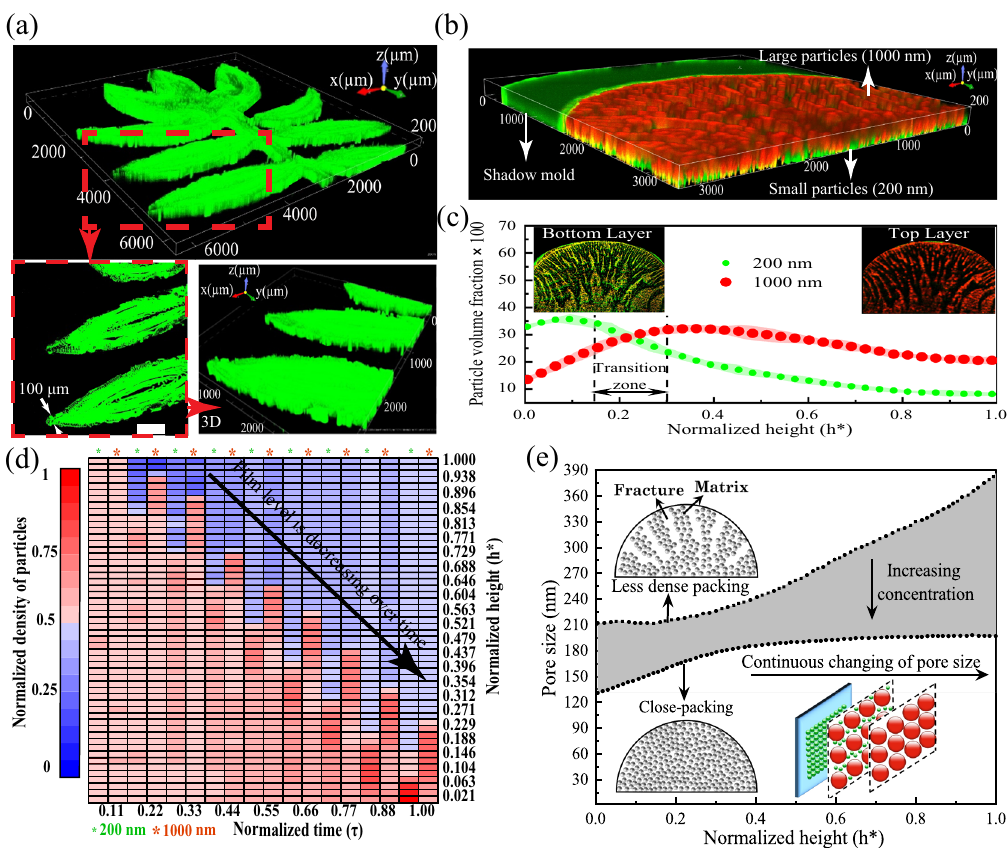
Fig. 4 Patterning and self-strati fi cation of fi ne- and microparticles using the proposed protocol. a Uniform patterning of fl uorescent polystyrene fi ne particles within a microscale patterned mold on a glass slide; scale bar: 500 μ m. b Patterning a multilayer nanocomposite consisting of two different particle sizes by self-organization of these particles as a result of different diffusion rates, demonstrating the capability of the protocol for patterning multifunctional layers. c Volume fraction of the fi ne- and microparticles versus normalized height shows the high intensity of the small fi ne particles (200 nm) at the bottom layers and an opposite trend for the large microparticles (1000 nm). Standard deviations are shown as shaded lines, with n = 3. d Heatmap of the deposition of the mixed particles over time, revealing the autostrati fi cation of the particles. e The average nanoscale pore size of the deposited fi ne- and microparticles, in close-packing and less dense packing states, shows the pore size gradient along with the layers. The shaded area represents the pore size range in higher concentrations of the particles with respect to the less dense packing case. Source data are provided as a Source Data fi